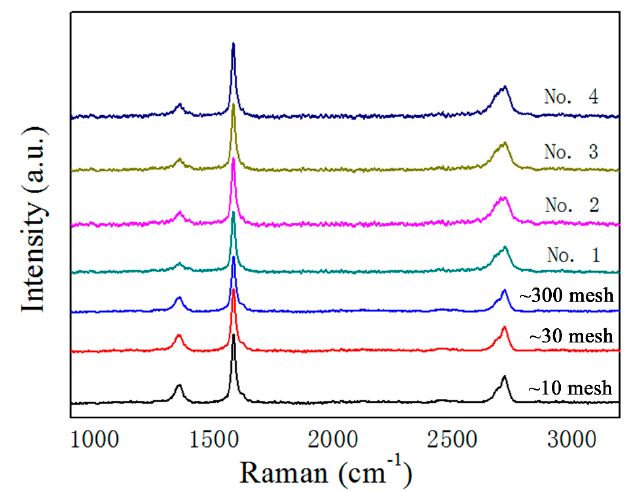
Figure 4. Raman spectra of graphite micro-flake powders and recovered samples.